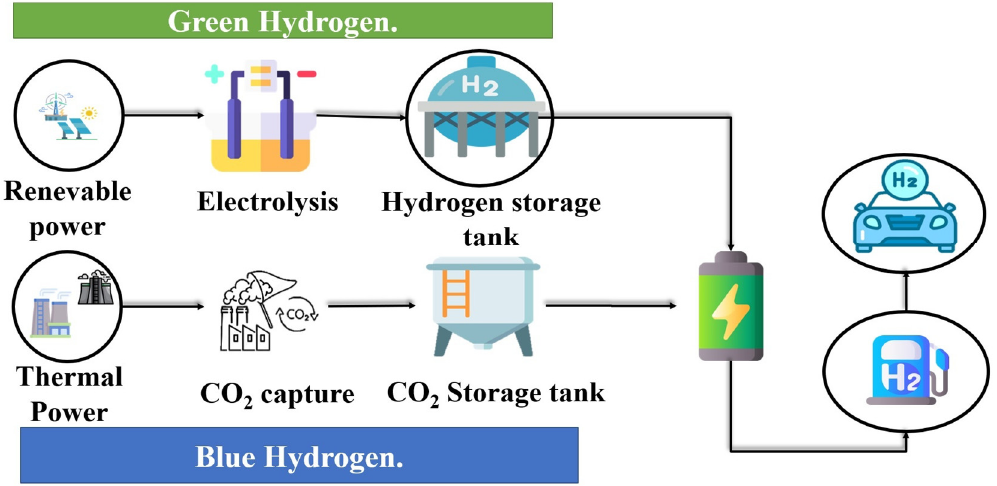
Figure 10. Abundant renewable source of energy.